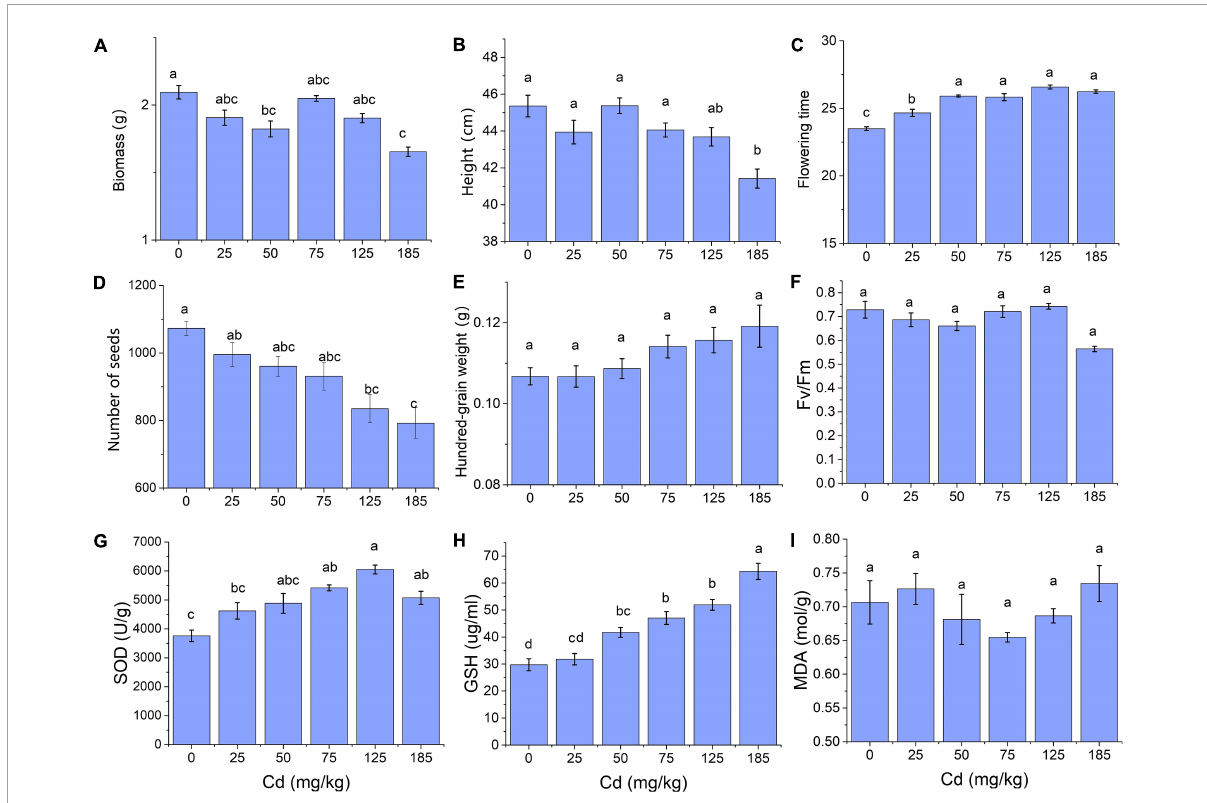
FIGURE2 Trait expression of field pennycress in response to different soil Cd concentrations. (A) Biomass; (B) individual height; (C) flowering days; (D) number of seeds; (E) hundred-grain weight; (F) Fv/Fm; (G) SOD; (H) GSH; and (I) MDA. Quoted values are means ± SE ( N = 6). Different letters indicate significant differences among groups determined by Tukey’s